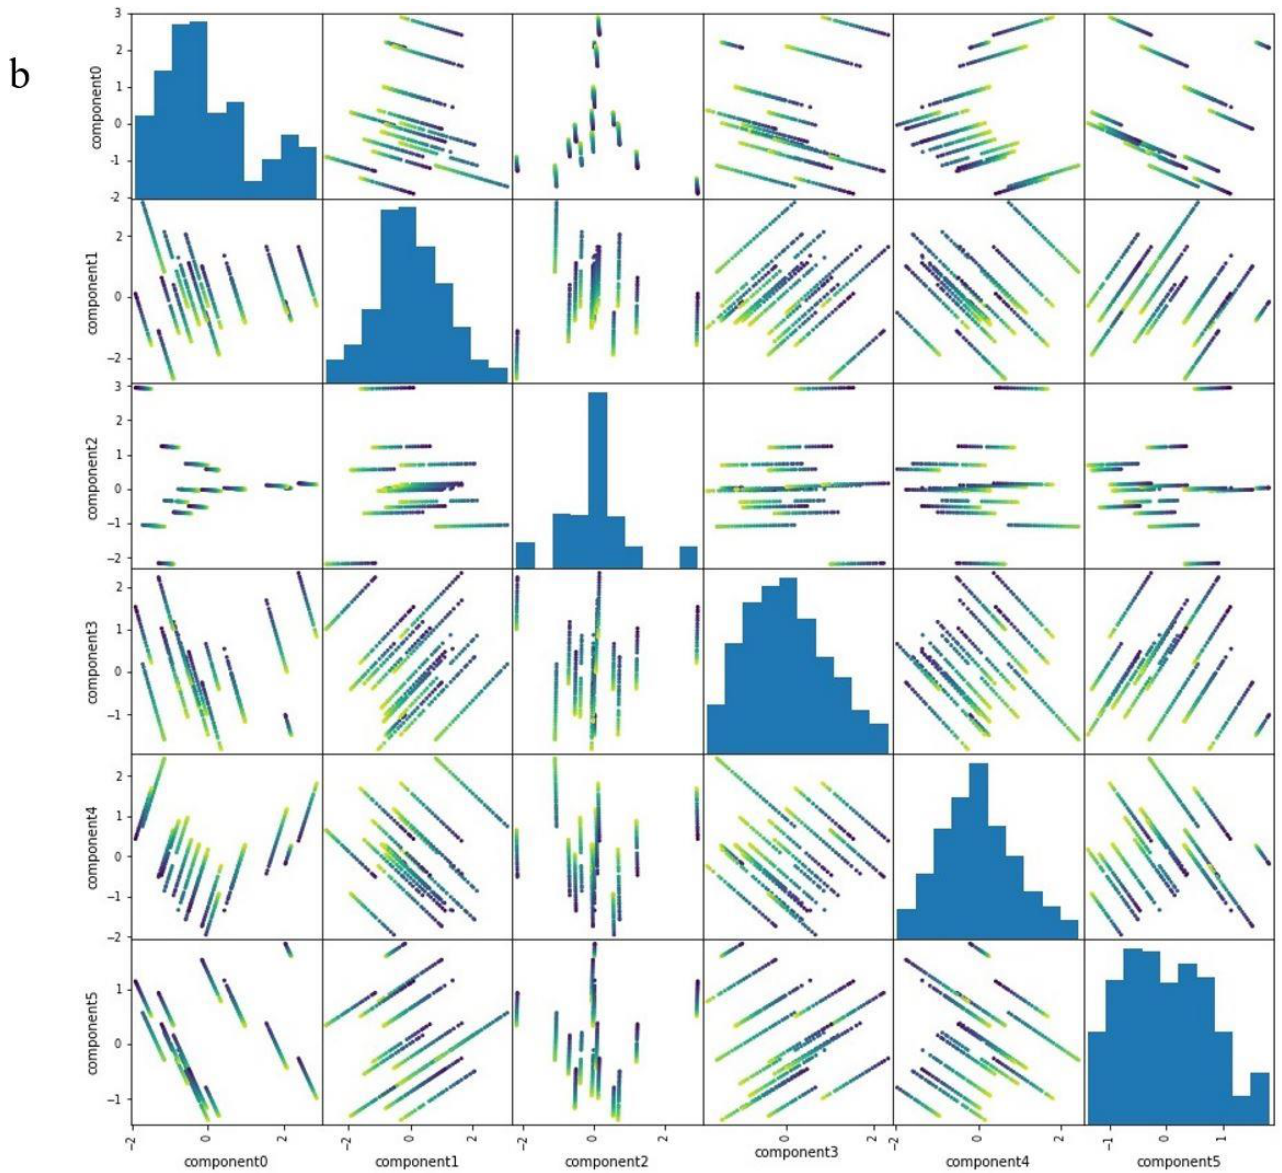
Figure 2. Distributions of ( a ) standard original features and ( b ) decomposed features using PCA.